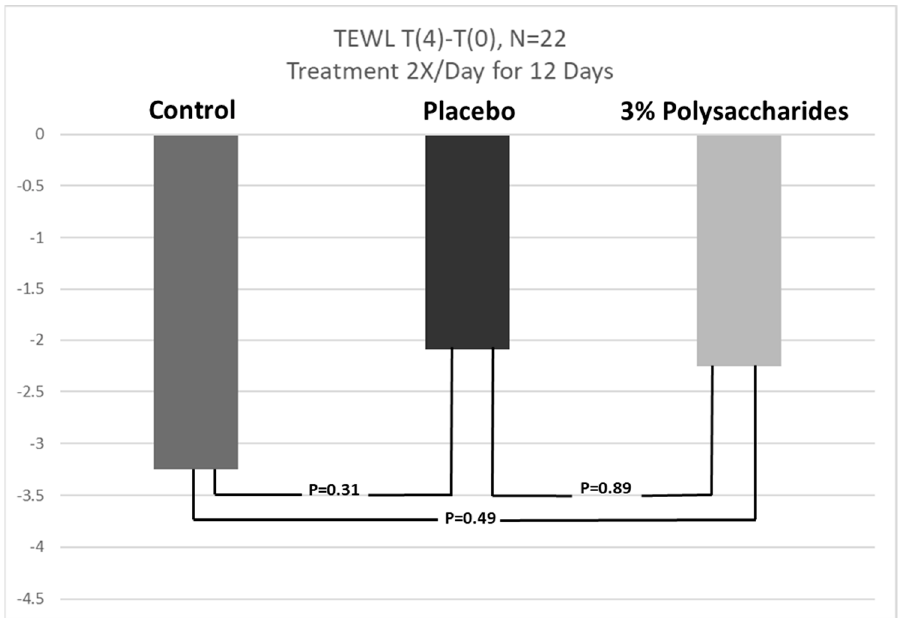
Figure 2. Results of Transepidermal Water Loss (TEWL) measurements (g / m 2 / h). Dark grey is the untreated control, black is the retinol placebo-treated and light grey is the polysaccharide active-treated sites. N = 22, p ≤ 0.05.